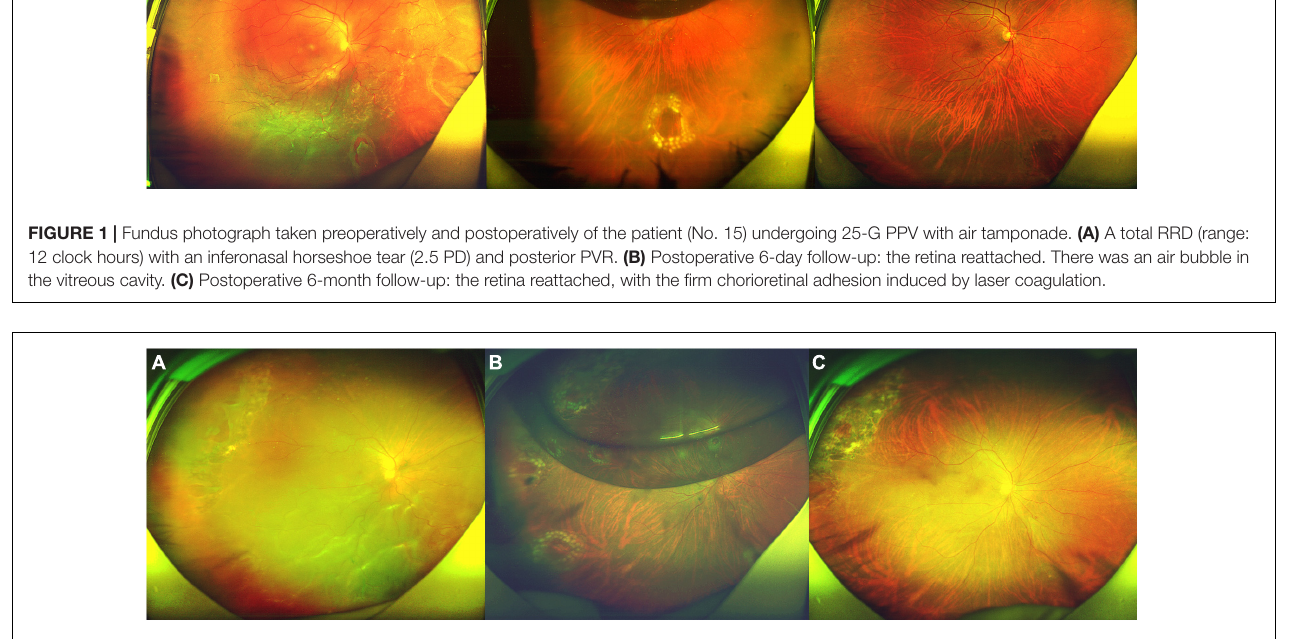
FIGURE 2 | Fundus photograph taken preoperatively and postoperatively of the patient (No. 27) undergoing 25-G PPV with air tamponade. (A) A macular-off RRD (range: 11 clock hours) with nine horseshoe tears in superotemporal, inferotemporal, and inferonasal quadrants and posterior PVR. (B) Postoperative 5-day follow-up: the retina reattached. There was an air bubble in the vitreous cavity. (C) Postoperative 4-month follow-up: the retina reattached, with the firm chorioretinal adhesion induced by laser coagulation.